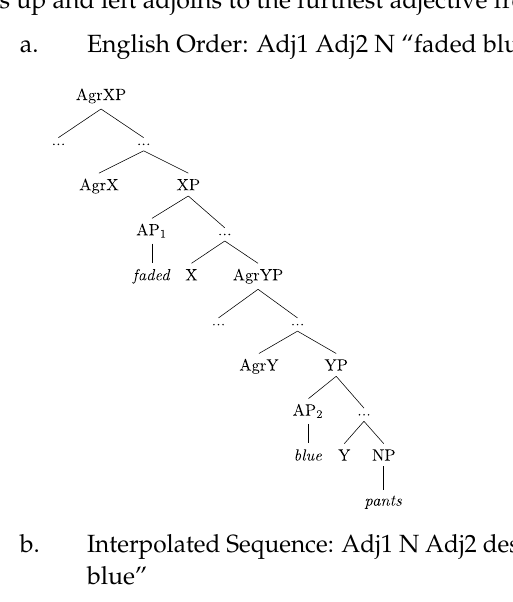
English Order: Adj1 Adj2 N “faded blue